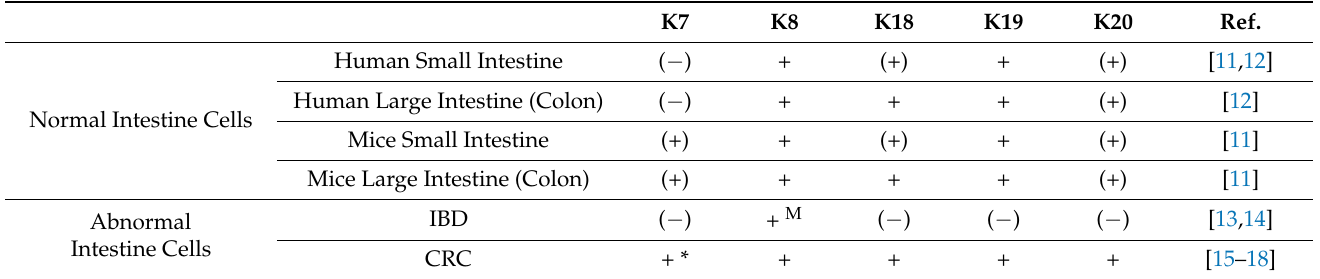
Table 1. Distribution of keratins in